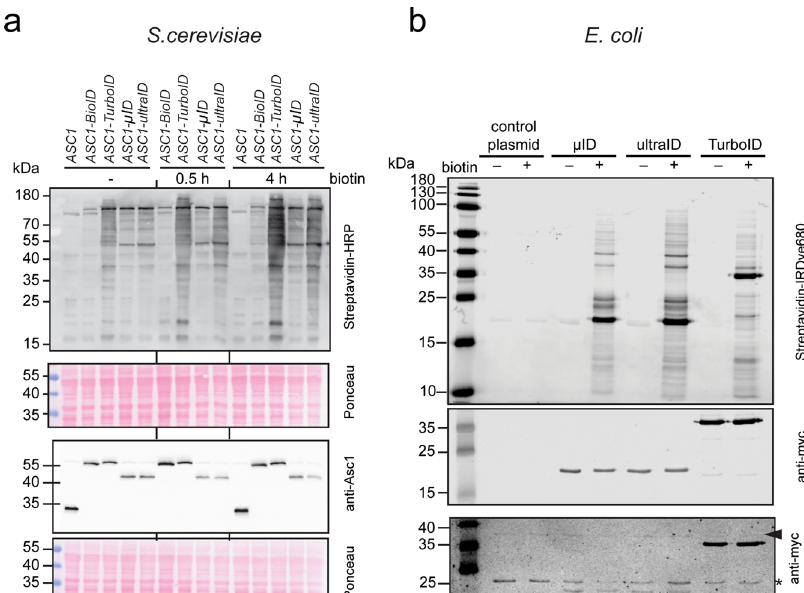
Fig. 6 PDB in yeast and bacteria with microID and ultraID. a Blots of lysates of S. cerevisiae strains expressing the indicated Asc1 fusion proteins and incubated or not ( − ) with 10 μ M biotin for the indicated times. The fusion proteins were expressed from plasmids in a Δ asc1 strain, and the ASC1 wild-type strain carrying the empty vector served as a control. Biotinylation was analyzed using HRP-labeled streptavidin and expression levels of the fusion proteins with antibodies against Asc1 as indicated. b Blots of lysates of E. coli cells transformed with expression plasmids for ultraID, microID, TurboID, or the control plasmid. The cells had been incubated ( + ) or not ( − ) with biotin for 16 h. The arrowhead indicated the expected size for bacterial GAPDH, and the asterisk (*) indicates a non-speci fi c cross-reactivity that was used as a loading